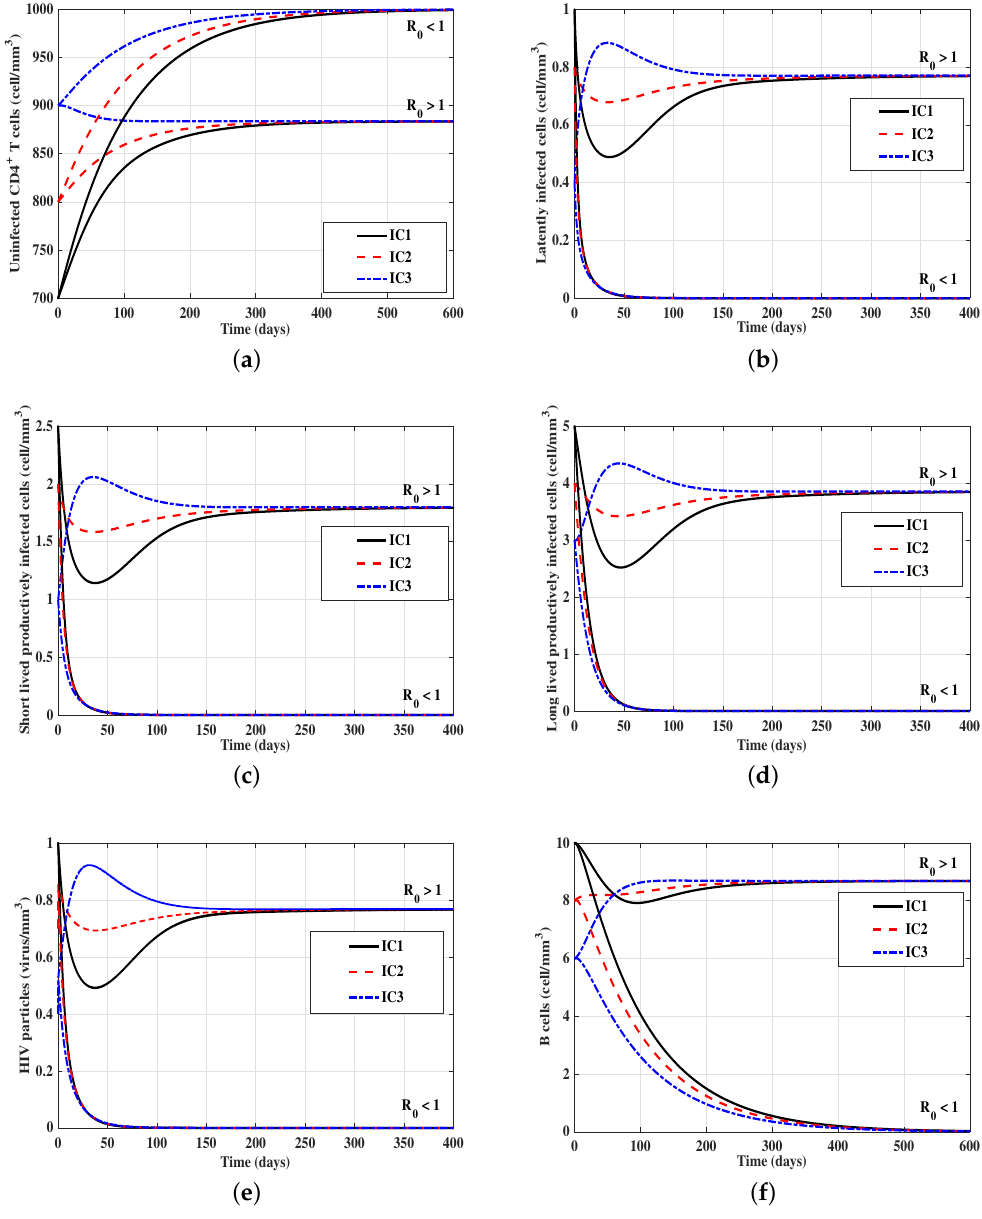
Figure 1. Plots showing the asymptotic stability of the infection-free equilibrium when α 1 = 0.003 ( R 0 < 1) and endemic equilibrium when α 1 = 0.0003 ( R 0 > 1) of models (15)–(20) with three initial conditions IC1–IC3. For this figure, we take α 2 = 0.5, ϑ = 0.01, λ = 0.01, and µ = 0.01. ( a ) Uninfected CD4 + T-cells; ( b ) latently-infected cells; ( c ) short-lived productively-infected cells; ( d ) long-lived productively-infected cells; ( e ) HIV particles; ( f )